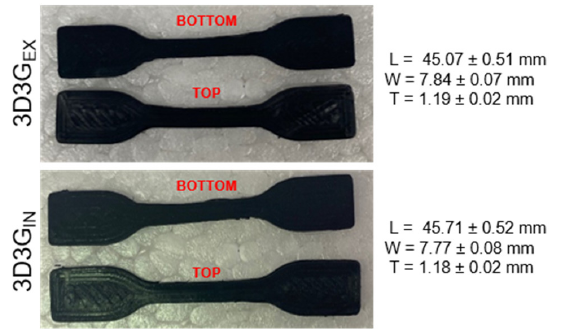
Figure 9. Photographs of 3D printed parts based on graphene systems.